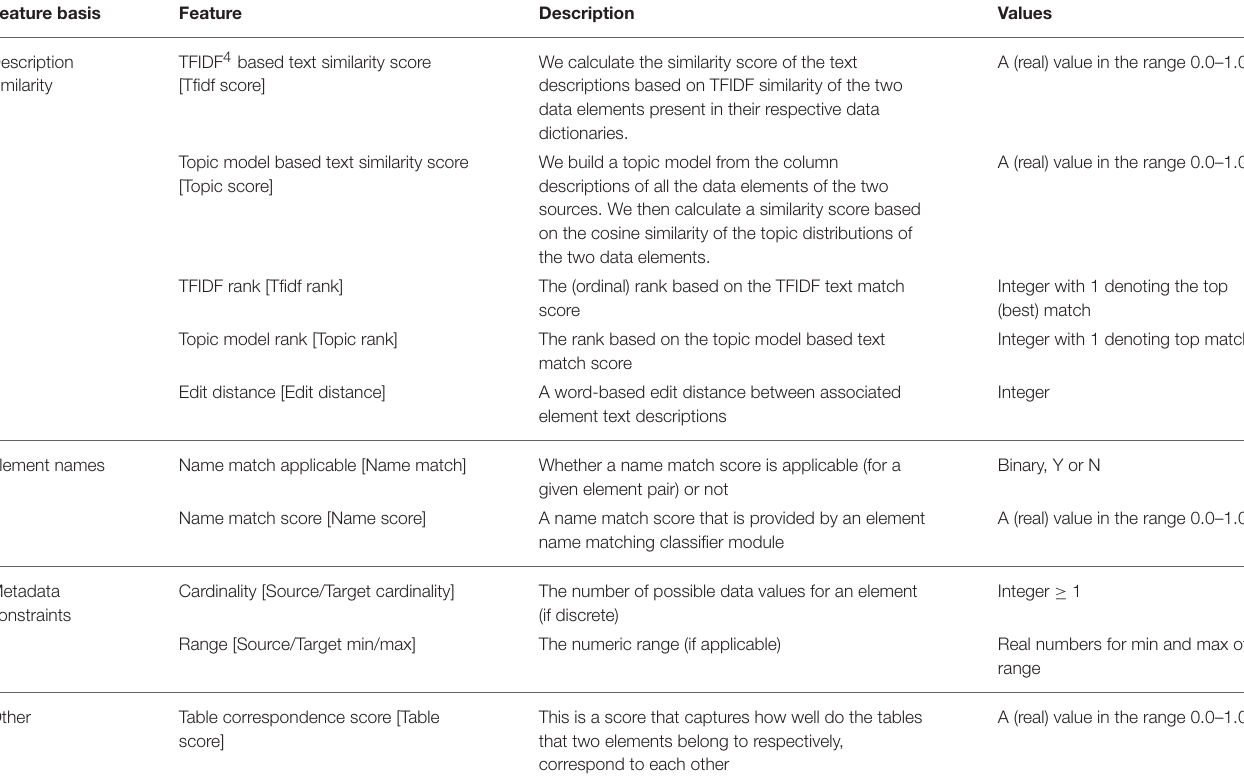
TABLE 1 | Set of features for